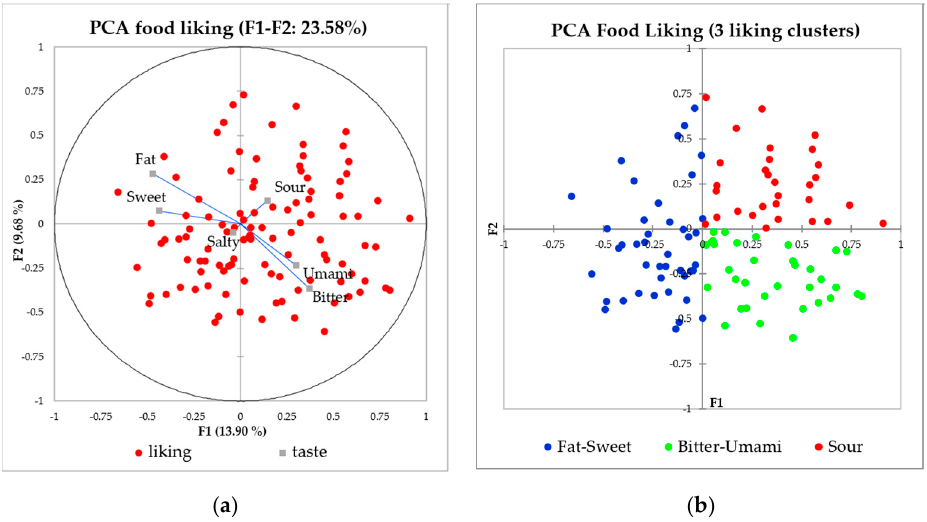
Figure 3. Loading from PC1–PC2 of the double-centered PCA on food liking ( a ) resulting in three taste-liking clusters of fat-sweet ( n = 42), bitter-umami ( n = 34), and sour ( n = 30) likers ( b ). The differences between the three liking clusters with respect to DT were analyzed using a two- (Figure 4, p = 0.024), with the highest DT (least sensitivity) observed for the fat-sweet group and lowest for the sour group. Moreover, the bitter-umami group had higher DT for sweetness, saltiness, caffeine-bitter, and quinine-bitter compared to the other groups, but without reaching statistical significance (Figure 4). The linear mixed models showed no influence of DT and taste responsiveness on the children’s food liking, the only strong effect observed was from the different taste qualities ( p < 0.001). Moreover, neither bitterness sensitivity from caffeine nor from quinine significantly influenced the liking of the bitter foods.